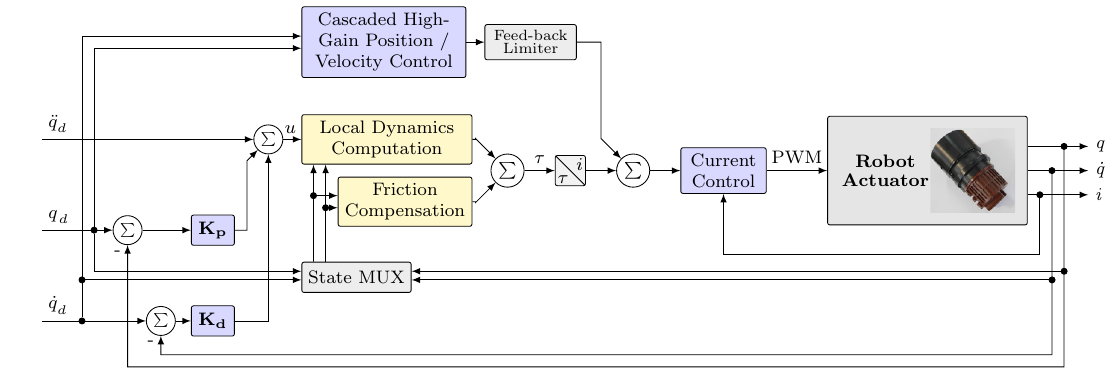
Fig. 7 Structure of the joint-level control loop including the dynamics model implemented on a FPGA